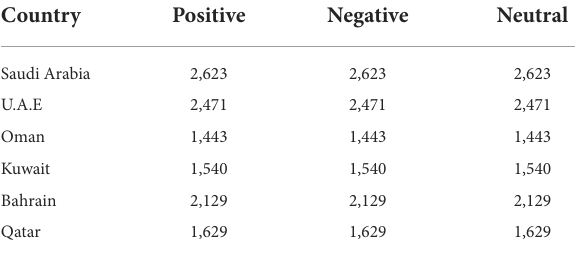
TABLE 3 The dataset after SMOTE was